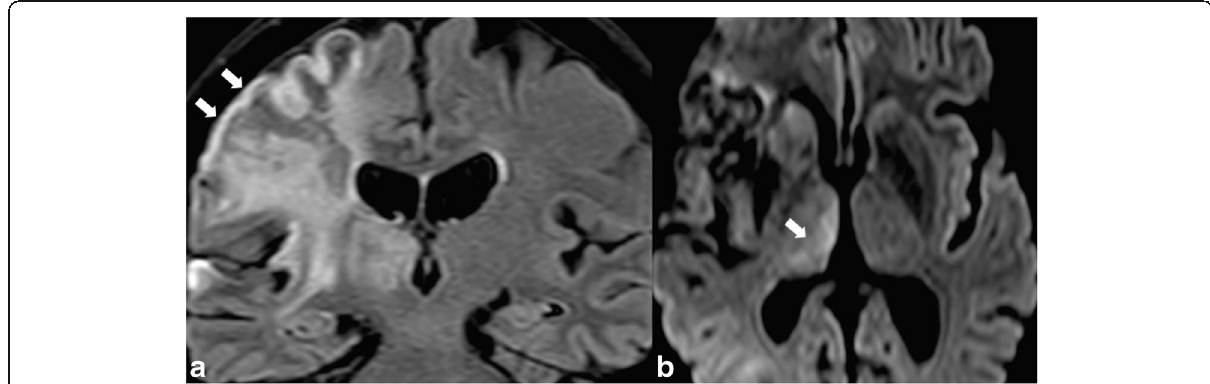
Fig. 15 FLAIR hyperintensity in the right temporal and insular regions (arrows in a ) reflecting brain ischaemia. An epileptic seizure ensued due to cortical involvement, which in turn resulted in high signal intensity on DWI b1000 in the right thalamus (arrow in b ) as a